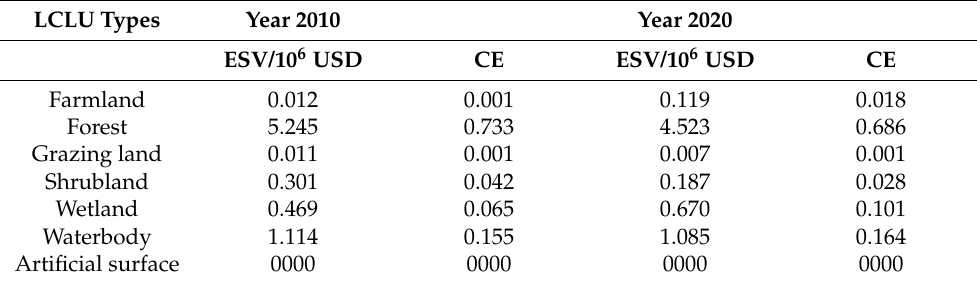
Table 9. Analysis of coefficient of elasticity.